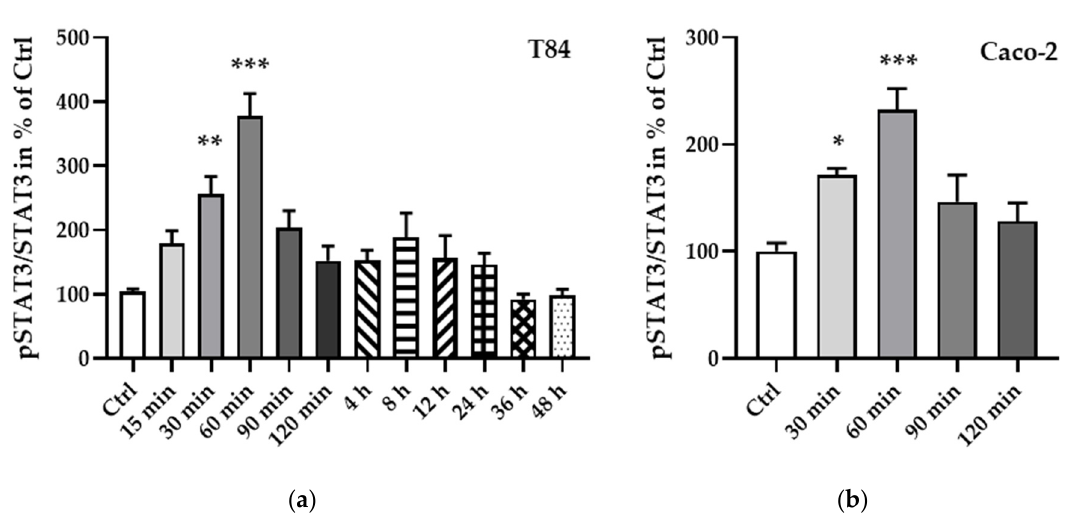
Figure 8. Phosphorylated STAT3 to total STAT3 ratio at different time points of leptin treatment in T84 ( a ) and Caco-2 cells ( b ). The phosphorylation of STAT3 becomes significant after 30 min of leptin treatment and peaks at 60 min in both cell lines. * p < 0.05, ** p < 0.01, *** p < 0.001, n = 6–11.